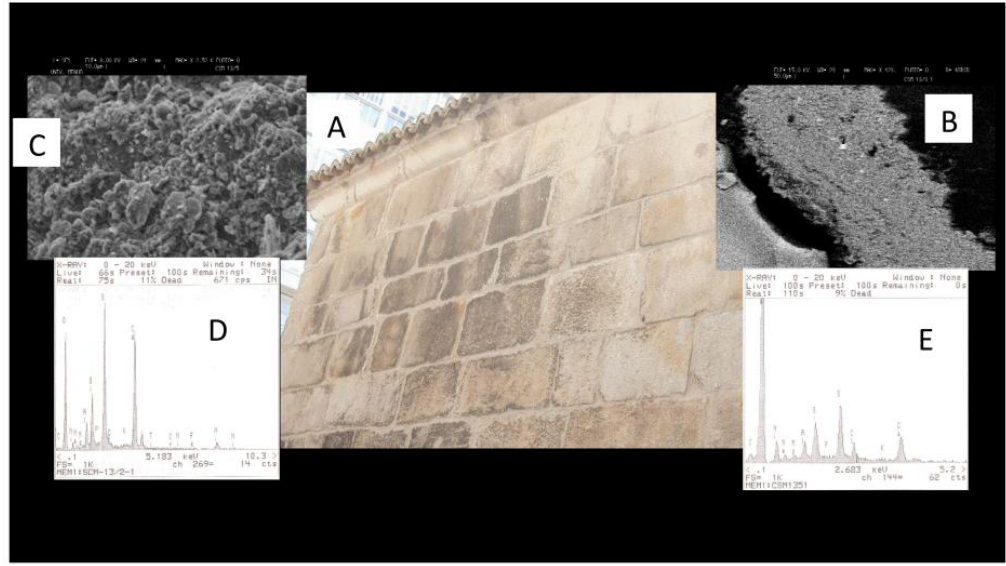
Figure 6. Covering layer on the façade of the Colegiata de Santa Maria del Campo (A Coruña). ( A ) Full view of the façade where the covering layer was taken, ( B ) SEM picture of the cross-section of the layer, ( C ) SEM picture of the surface of the layer, and ( D , E ) EDS of the layer